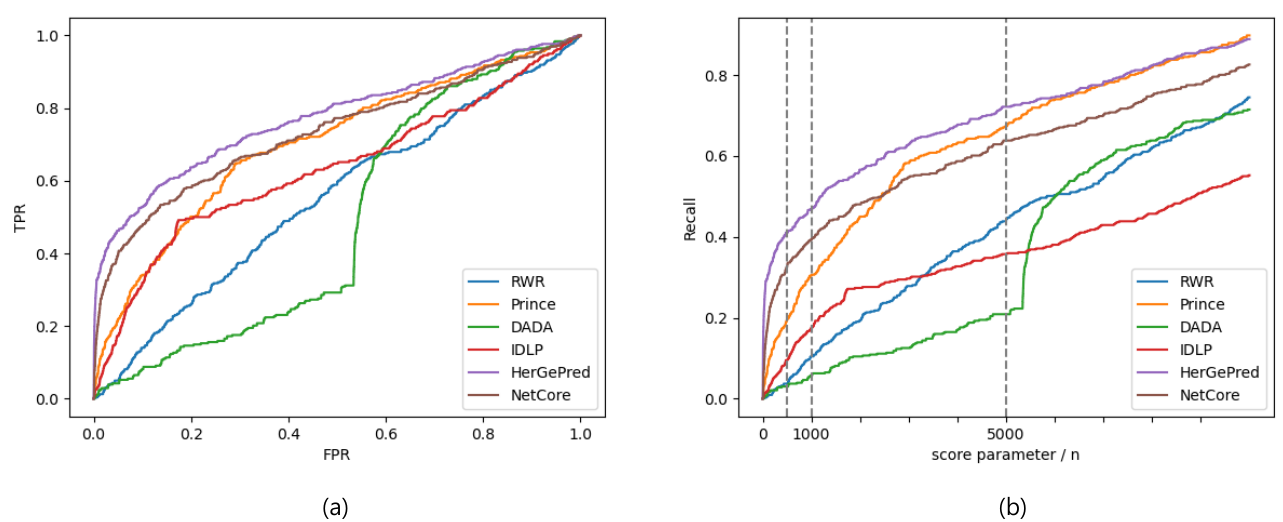
Figure 2. ROC ( a ) and recall ( b ) curves evaluated by prediction scores for disease-gene association prediction with known disease-associated genes.